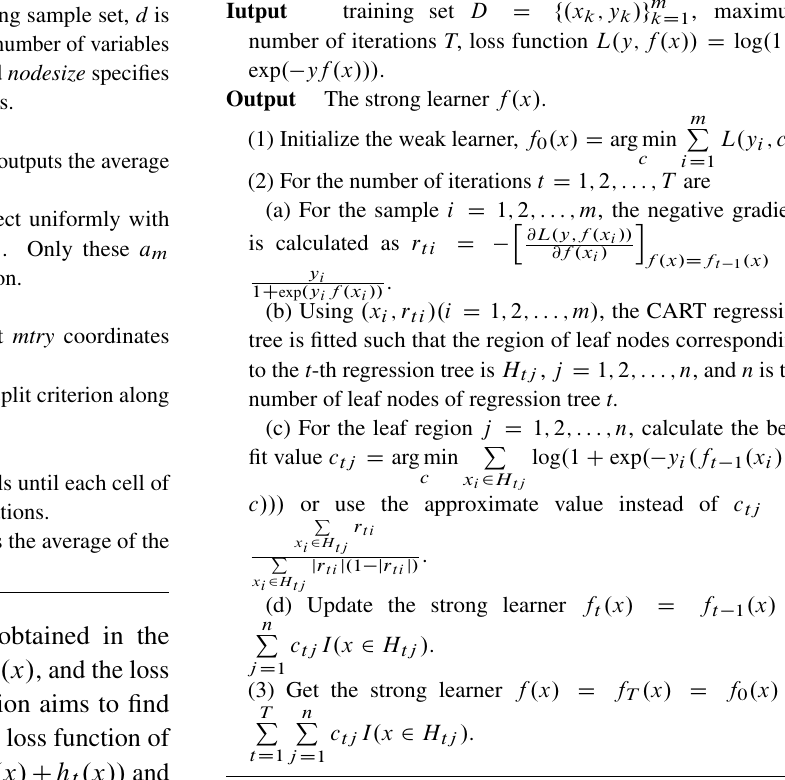
Algorithm 3 Random forest algorithm Algorithm 4 GBDT algorithm